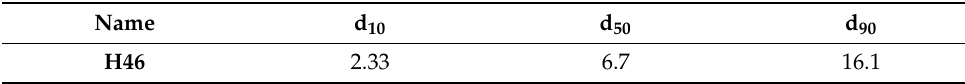
Table 3. Particle size of the masteralloy used [9].